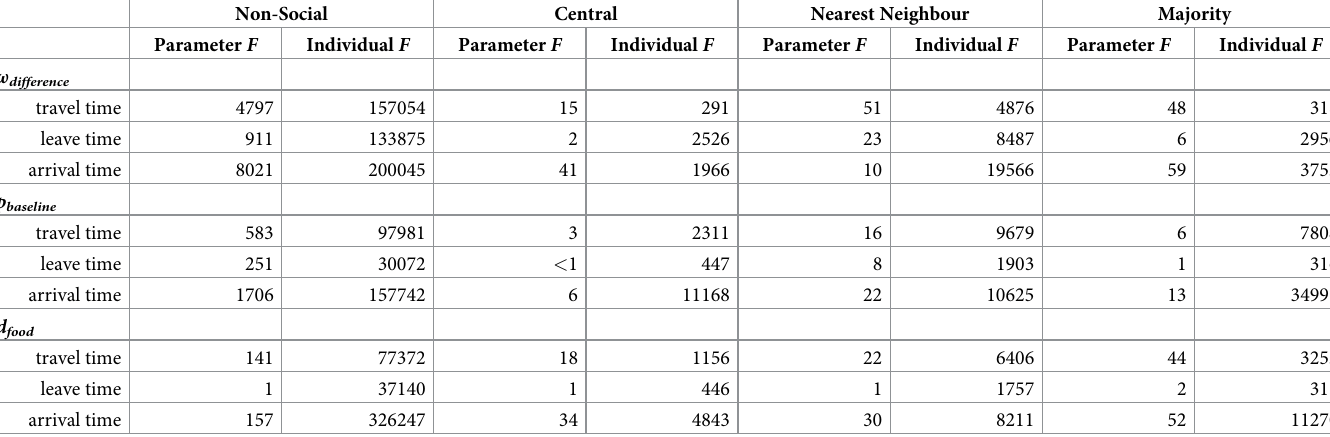
Table 2. F values describing the contributions of both the model parameter being varied and the ‘boldness’ of the individual within a simulation, according to the behavioural metric measured and the parameter being varied. Non-Social Central Nearest Neighbour